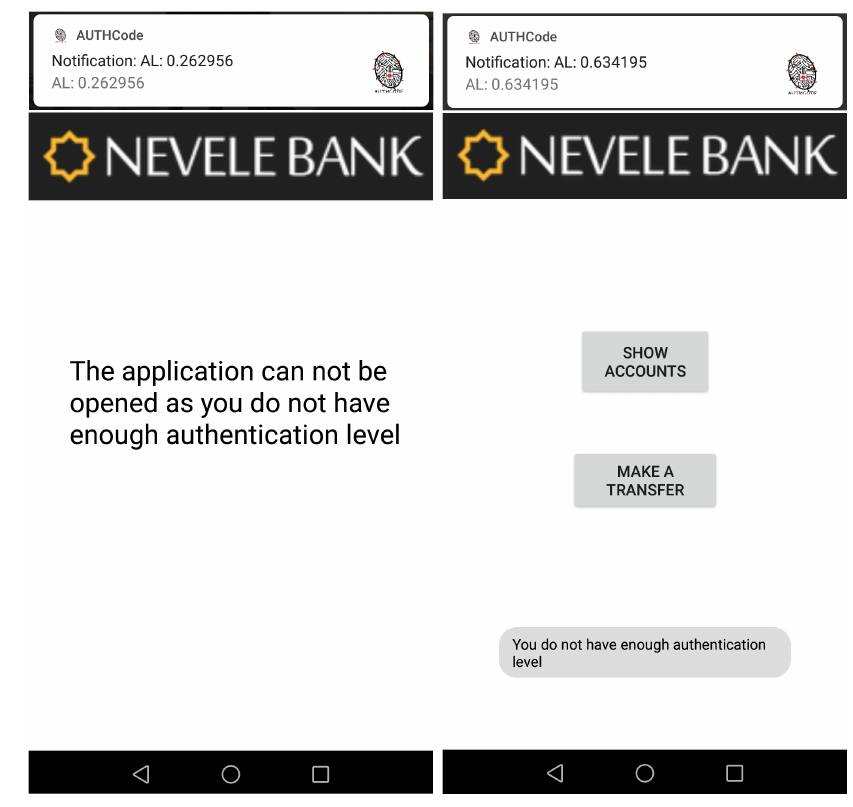
Figure 12. UserB using the online banking